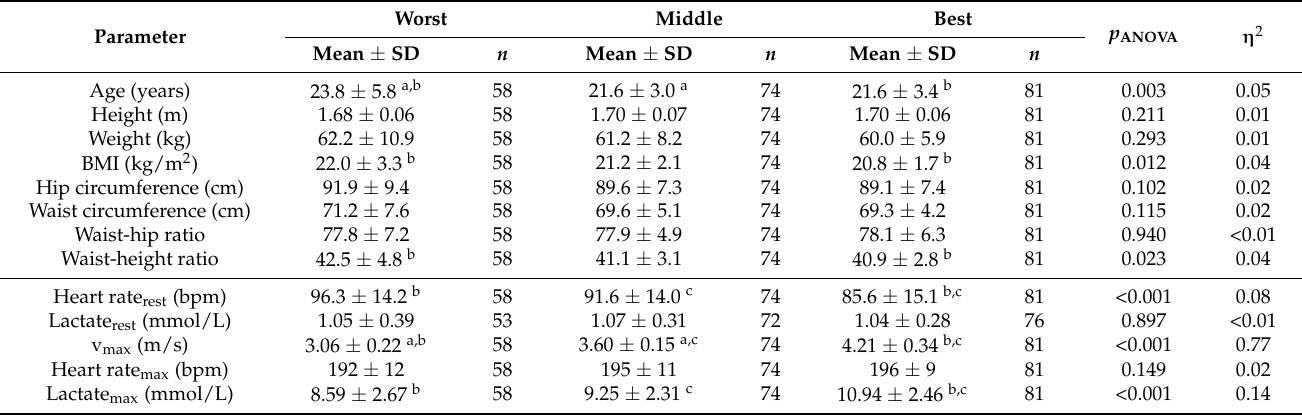
Table 3. Women’s characteristics, divided by performance